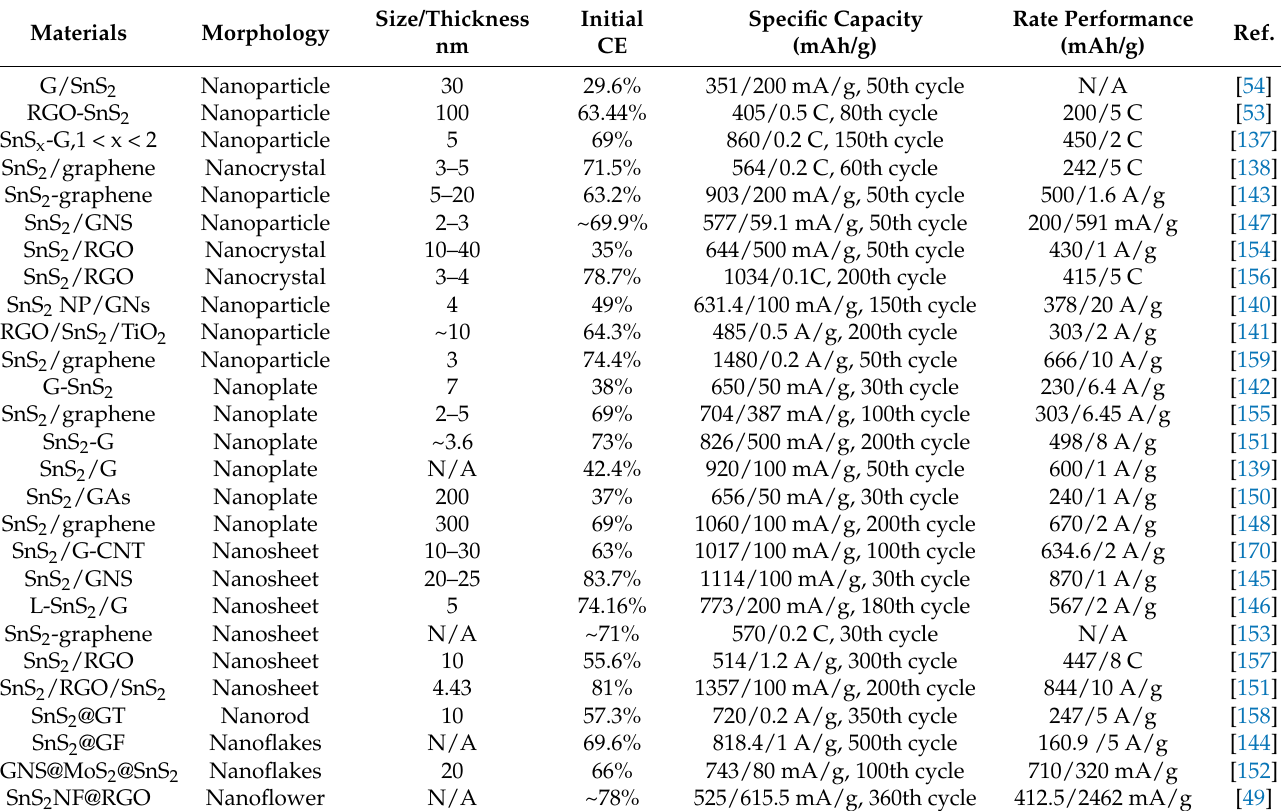
Table 3. Electrochemical performance of SnS 2 /graphene-based